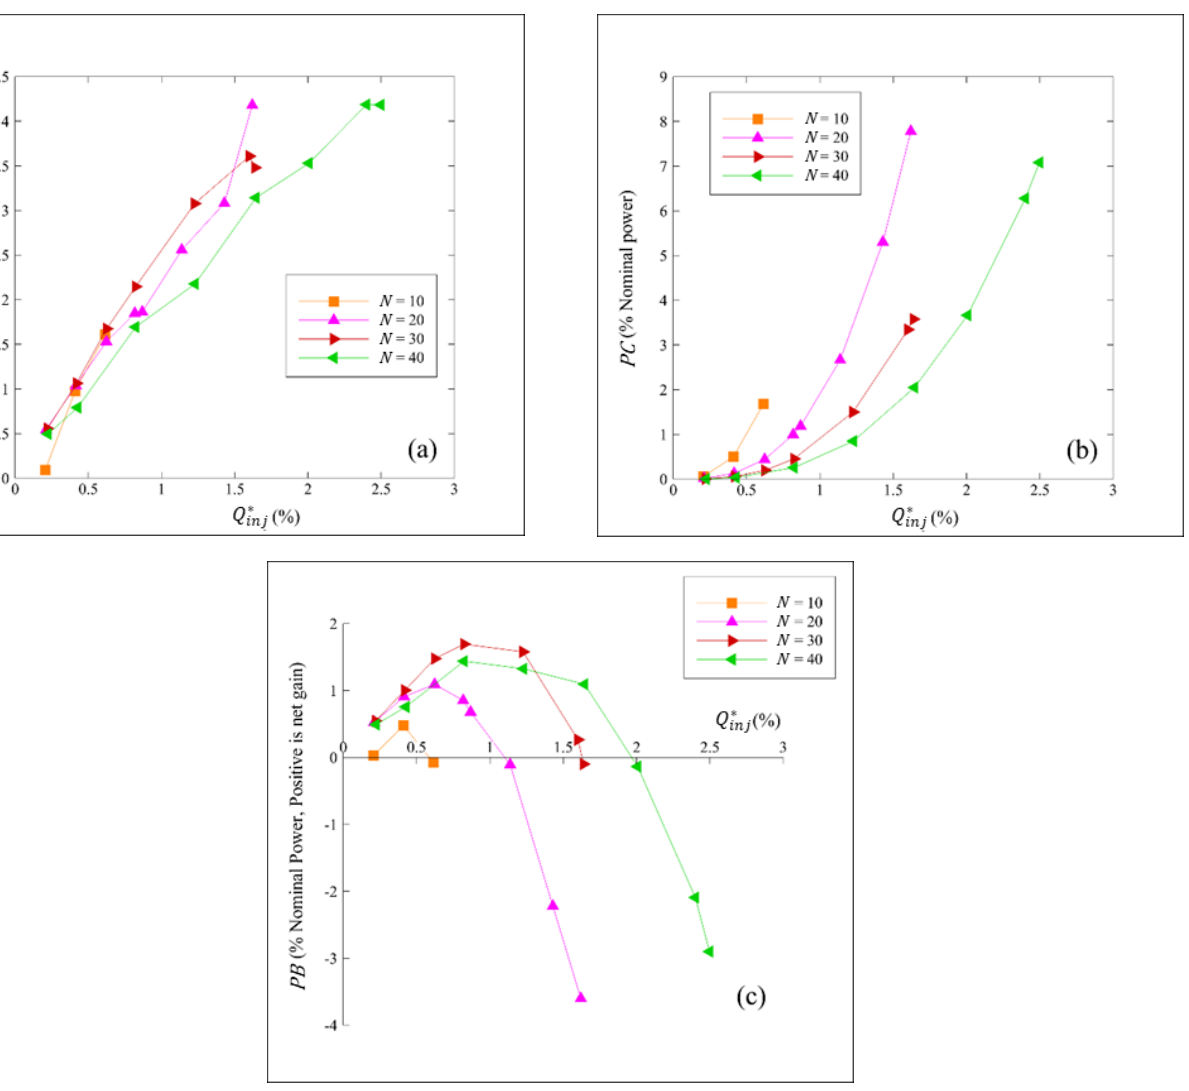
Figure 11. Evolution of the: ( a ) power gain, ( b ) power cost and ( c ) power balance as a function of the injected flow rate. Continuous blowing with the absolute injection angle 𝛼 𝑗𝑒𝑡 = −30° and the rotation speed 𝛺 = 3200 rpm.